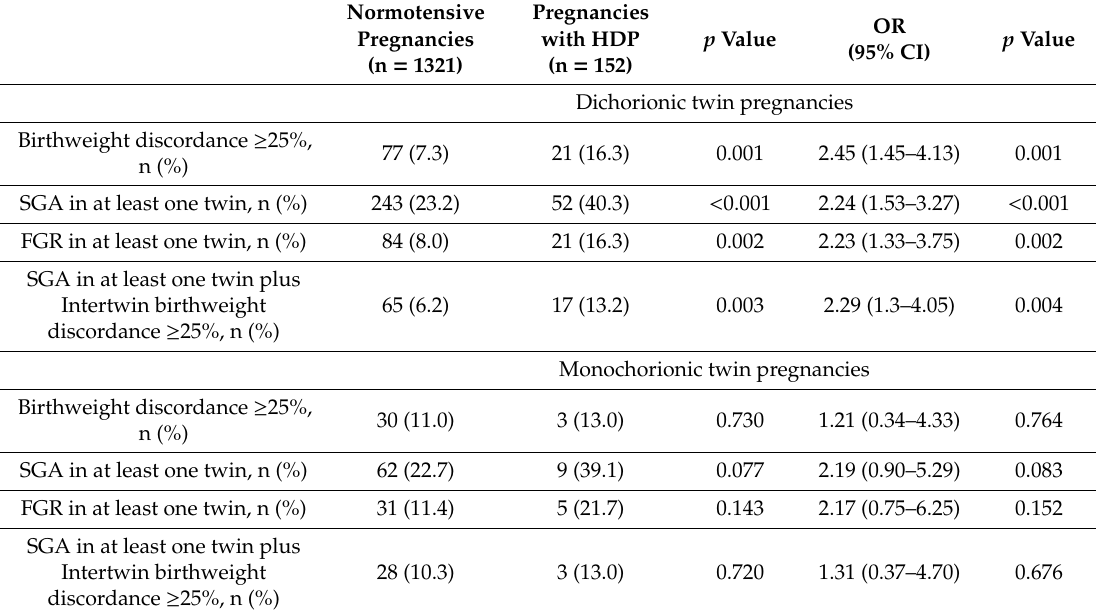
Table4. Theassociationbetweenintertwinweightdiscordance, fetalgrowthrestrictionandhypertensive disorders of pregnancy, stratified by